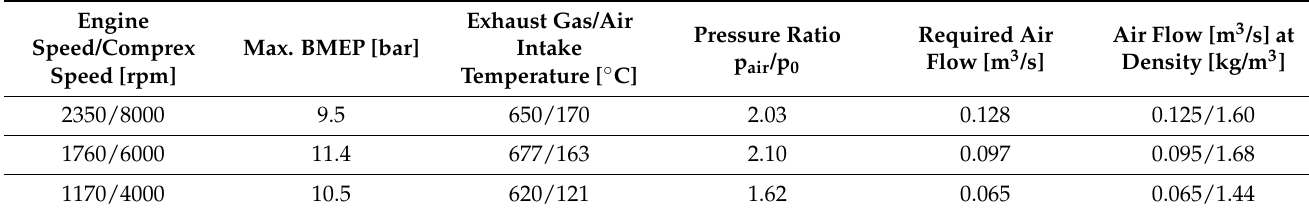
Table 1. Experimental data when using Comprex with a 5.9 L Diesel engine (1960)